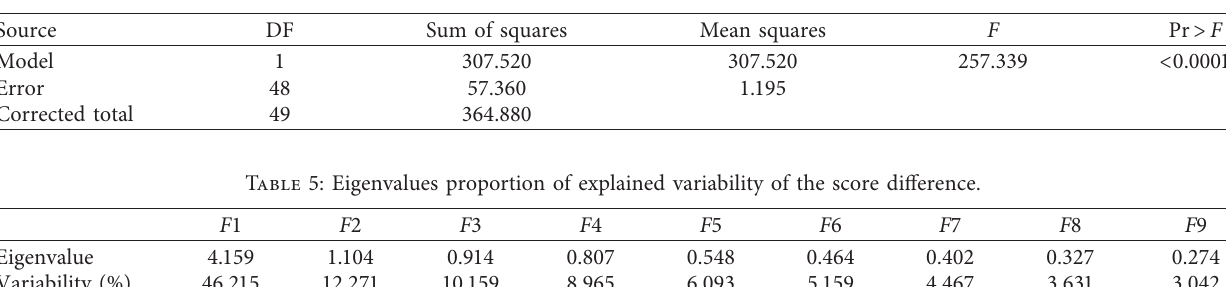
Table 4: ANOVA test of mean scores of volcanoes exam.